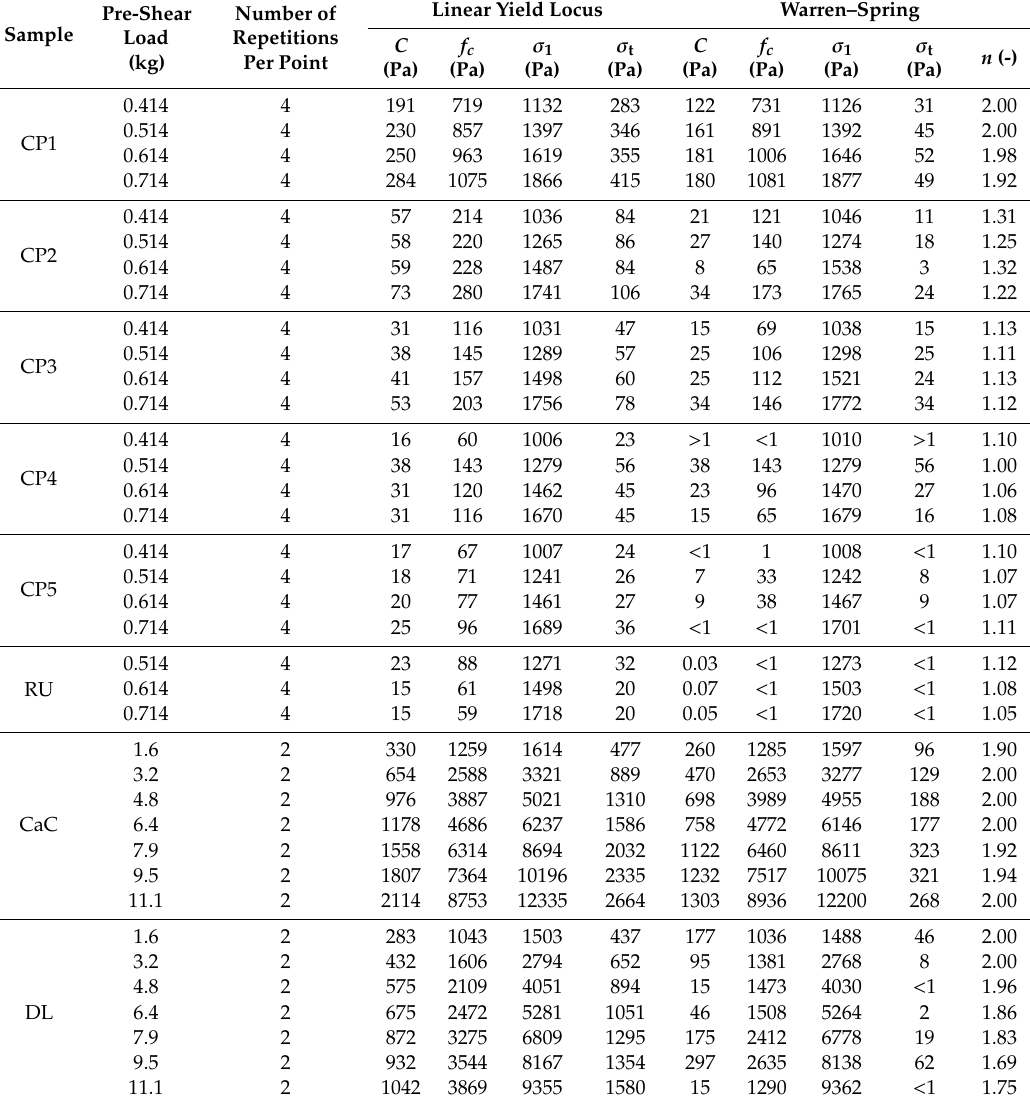
Table 2. Values of mean flow properties as function of the model yield